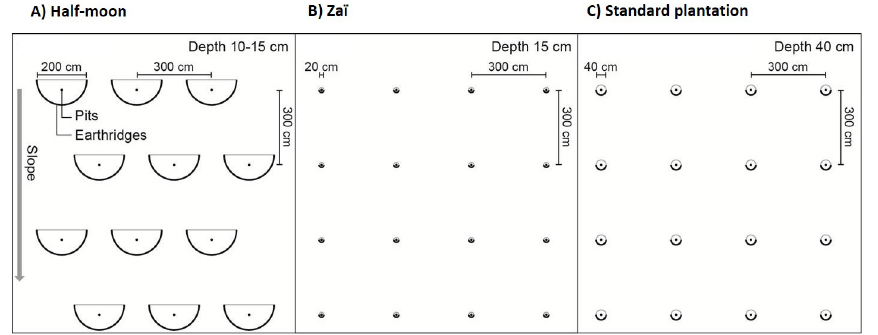
Figure 3. Specifications of restoration techniques.